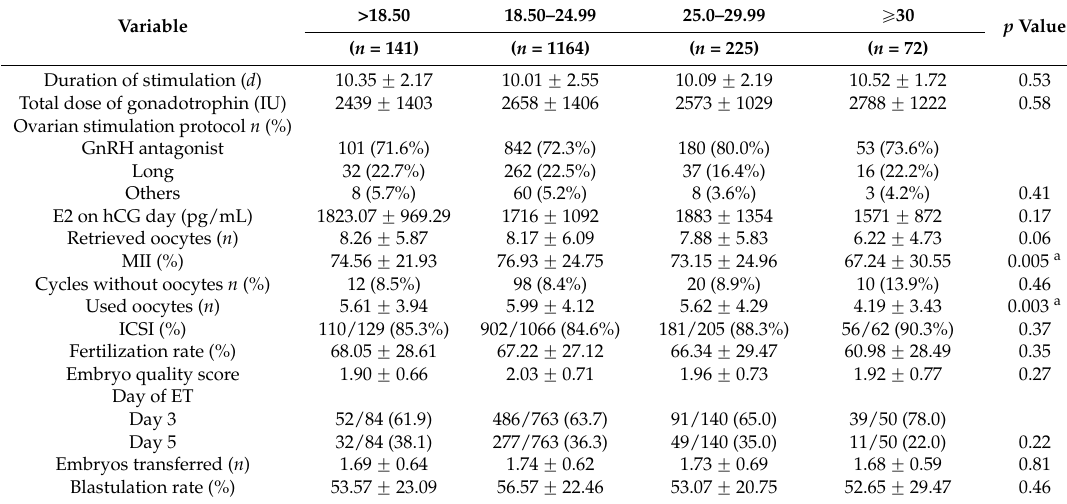
Table 2. Cycle characteristics by female BMI.